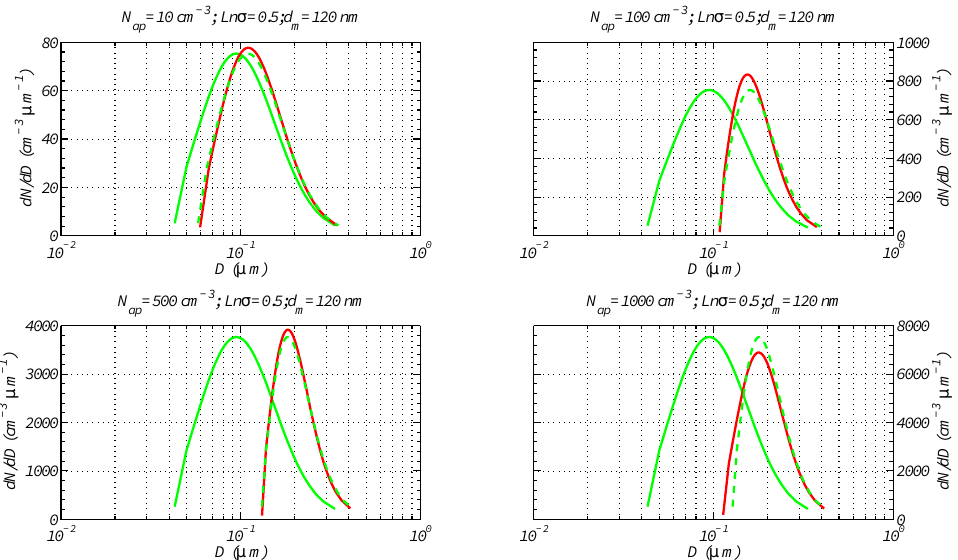
Fig. 4. Particle size distributions before and after co-condensation just below cloud base. Top left is for total aerosol concentration of 10cm − 3 , top right is for 100cm − 3 , bottom left is for 500cm − 3 and bottom right for 1000cm − 3 . The green solid line is the aerosol particle distribution with a semi-volatile content equal to the 0% RH equilibrium value, whereas the red solid line is the aerosol particle distribution after further co-condensation of semi-volatiles (this excludes the liquid water so is only the effective ‘dry’ aerosol size). The green dashed line is the original aerosol size distribution that has been shifted in diameter space by a constant factor. These aerosol size distributions are plotted on a logarithmic scale for the diameter.